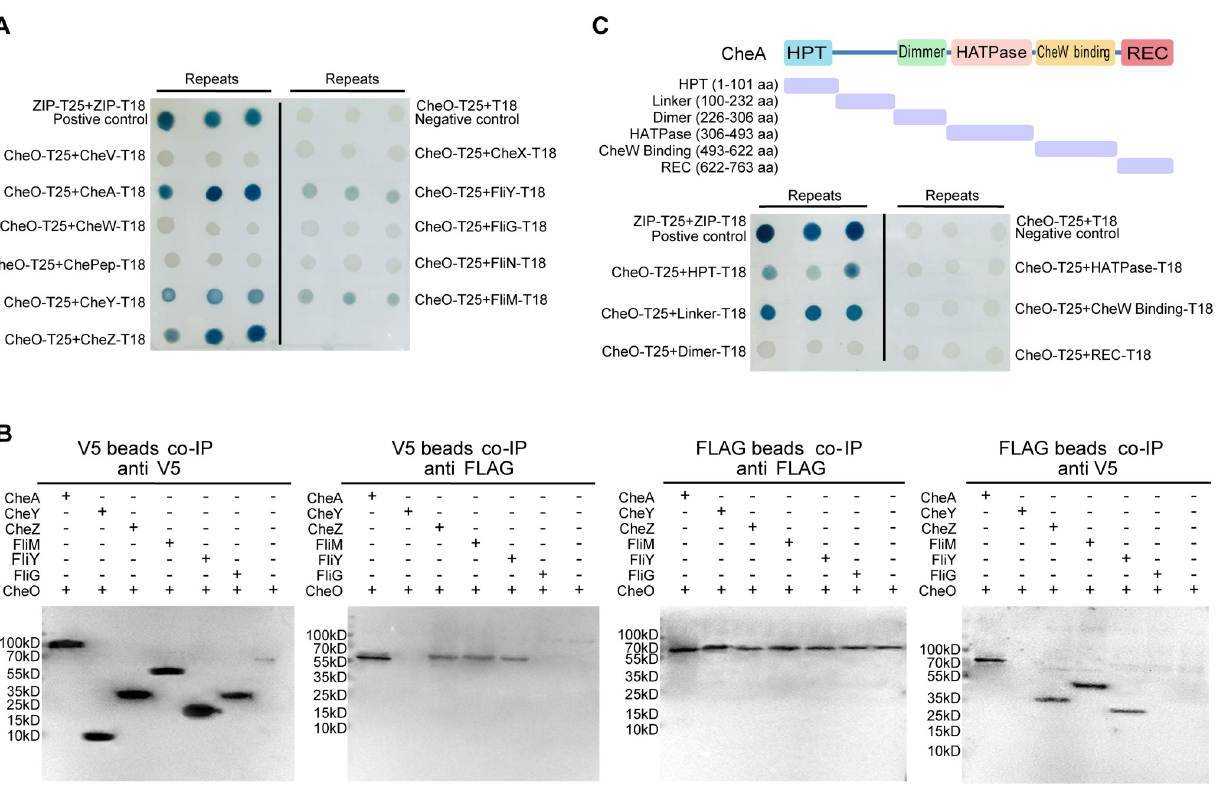
Fig 4. Interactions between CheO and multiple chemotaxis and flagellar rotor components. (A) BTH analysis for interactions between CheO and chemotaxis & flagellar components. The formation of blue colonies shows that a protein-protein interaction occurs. (B) Pull-down assays of CheO with potential interacting proteins from BTH analysis. CheO was fused with 3X FLAG-tag and the interacting candidates were fused with V5-tag. V5-tag beads co-IP products were verified by western blotting using primary antibodies against V5-tag (bait) and FLAG-tag (prey); FLAG-tag beads co-IP products were also verified by western blotting using primary antibodies against FLAG-tag (bait) and V5-tag (prey). FliG serves as a negative control. (C) BTH analysis for CheO and each domain of CheA. The purple fragments indicate the truncated fragments of CheA.